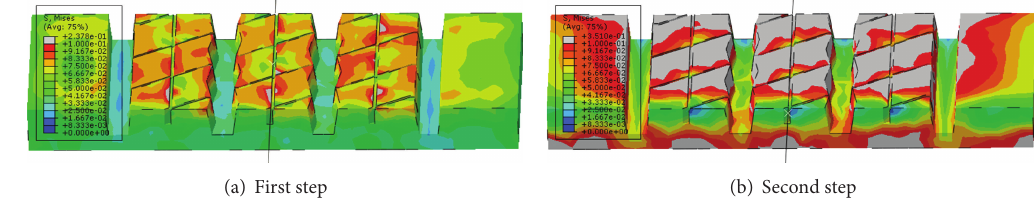
Figure 13: Distribution of von mises stress for tread block under the conditions: 𝛼 = 6 ∘ and 𝛽 = 8 ∘